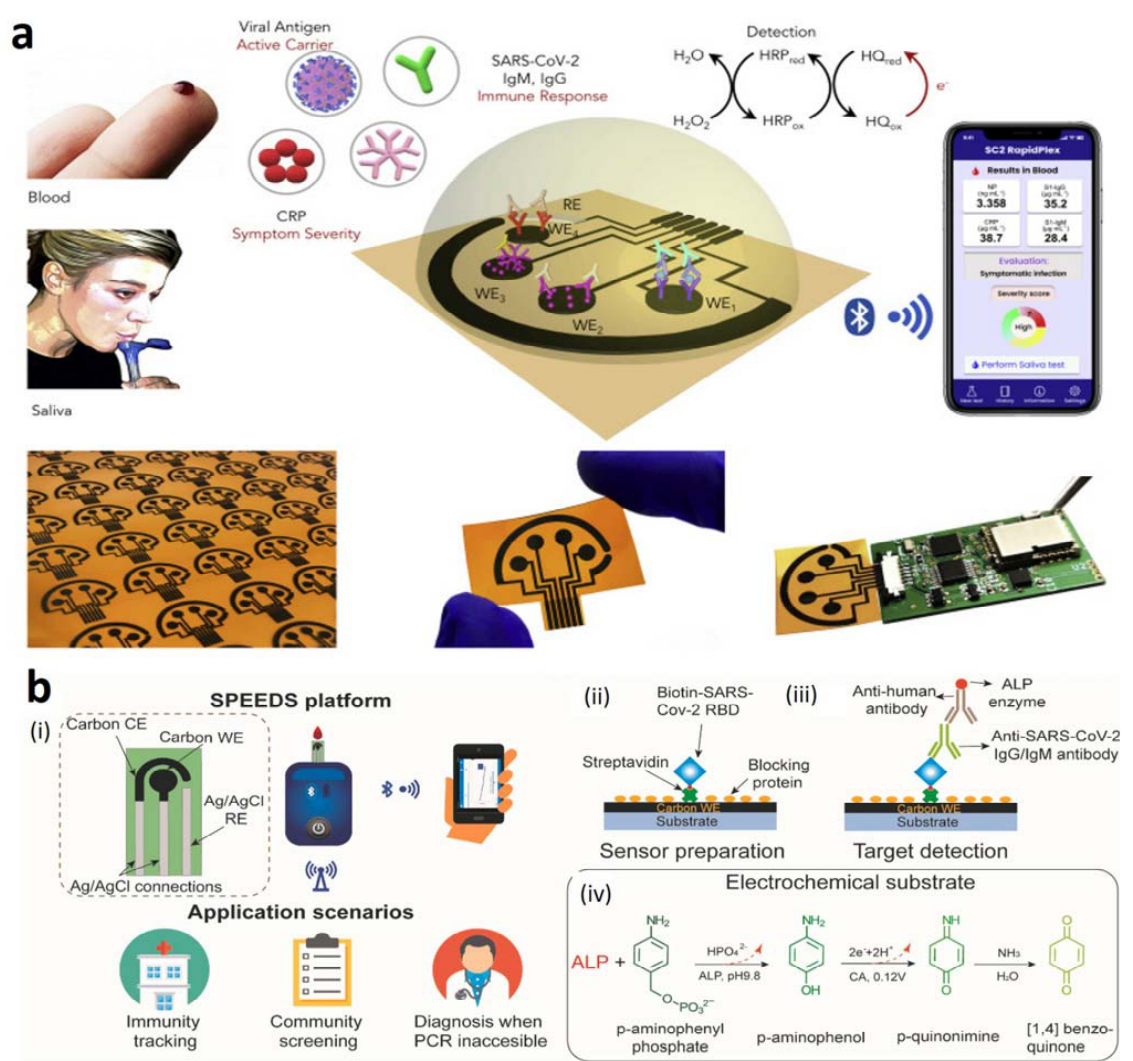
Figure 4. ( a ) Schematic illustration of the RapidPlex multisensor platform wirelessly transmitted to a mobile user interface for detection of IgG and IgM antibodies of SARS-CoV-2 viral proteins and inflammatory biomarker C-reactive protein (CRP), the photograph of mass-producible sensor arrays, single disposable and flexible graphene array, and the image of the RapidPlex system attached to a printed circuit board (adapted with permission from ref. [62]). Copyright 2020 Elsevier. ( b ) Schematic illustration of the (i) design of portable and rapid electrochemical detection of IgG and IgM antibodies against SARS-CoV-2 spike glycoprotein, (ii) surface functionalization of the carbon-based working electrode with biotinylated receptor-binding domain protein, (iii) binding of IgG or IgM antibodies on the sensor probe and subsequent labeling with alkaline phosphatase-conjugated detection antibody, and (iv) reaction mechanism for the electrochemical oxidation of p-aminophenyl phosphate substrate (adapted with permission from ref. [63]). Copyright 2022 Elsevier.